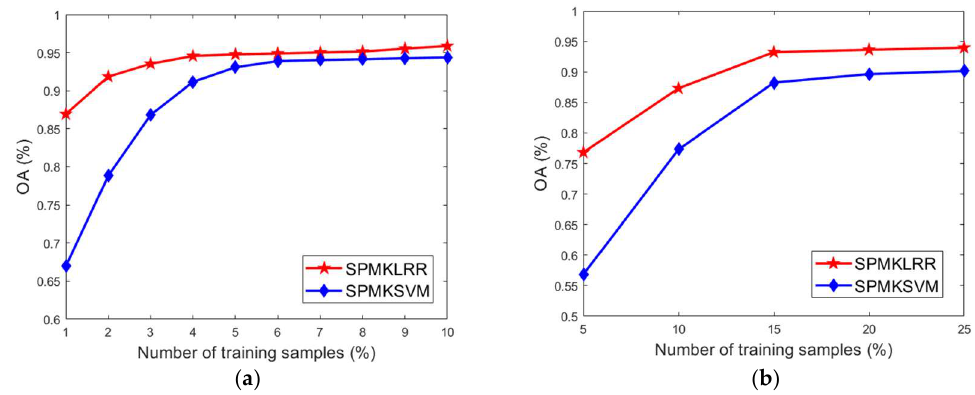
Figure 7. Impact of the number of training samples. ( a ) Indian Pines dataset and ( b ) University of Pavia dataset.